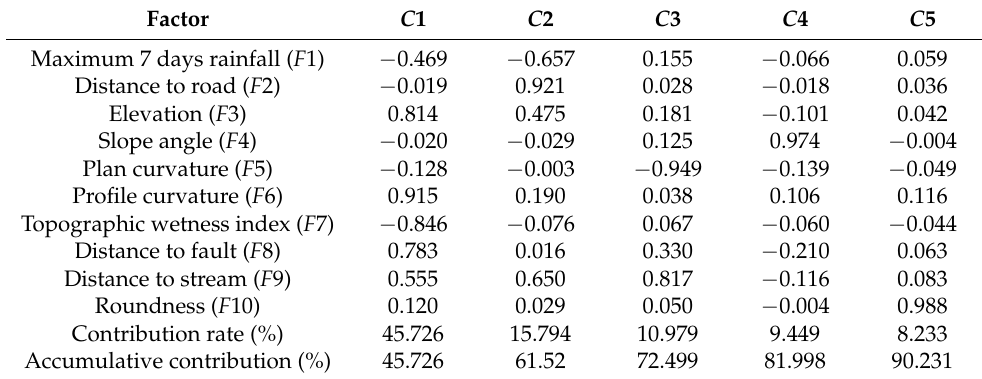
Table 7. The correlation coefficients between principal components and original variables.